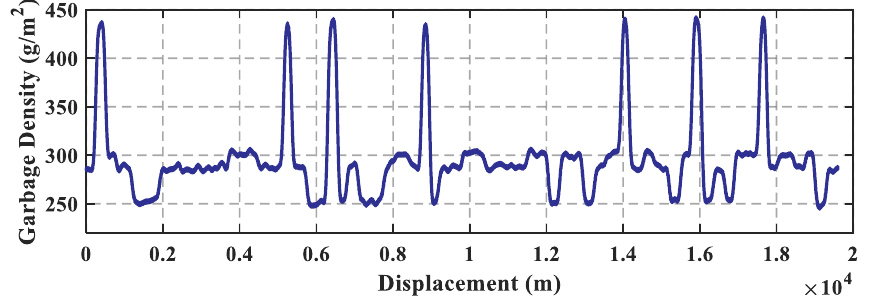
Figure 13. Garbage density distribution model.